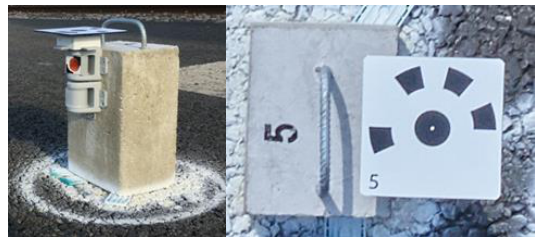
Fig. 2: The structure of the marker with the prisms: left side view: the centres of the three elements are arranged collinearly, the distances are known. Right: marker in aerial view.